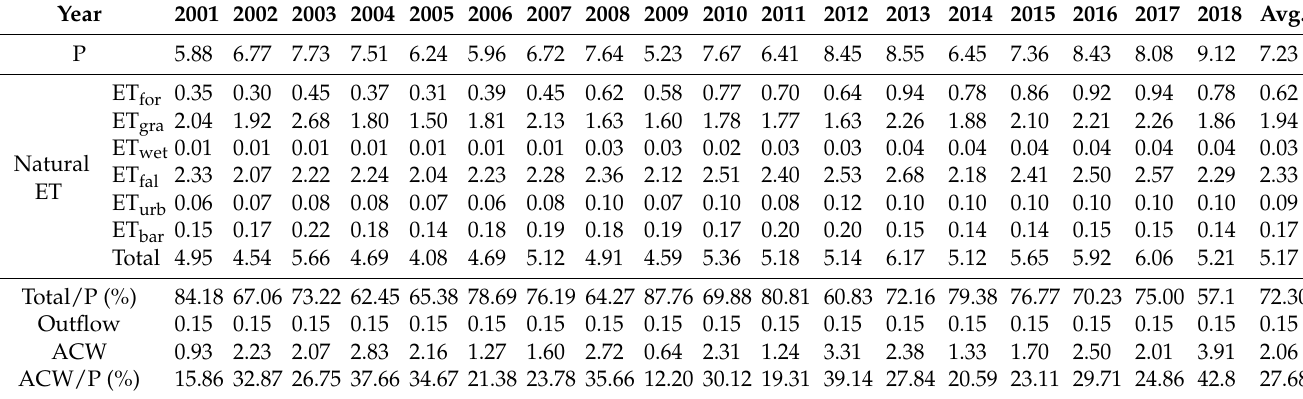
Table 3. Precipitation, natural ET, ACW, and outflow from the UCTRYDR from 2001 to 2018 (10 9 m 3 ).